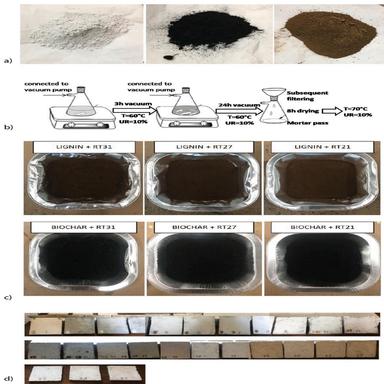
a) pure elements used: gypsum, biochar and lignin b) steps followed to obtain the impregnated compounds c) impregnated compound with lignin and biochar matrices d) photo of the 25 panels produced.